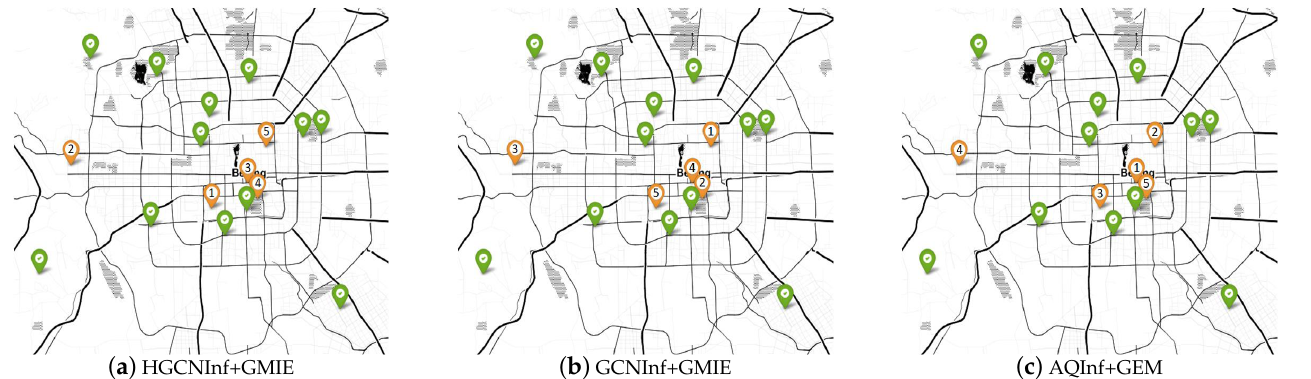
Figure 12. The recommendation results of each model. The nodes marked with orange symbols in the figure are candidate nodes. Each candidate node has a recommendation priority marked by Arabic numerals (the smaller the number, the higher the recommendation